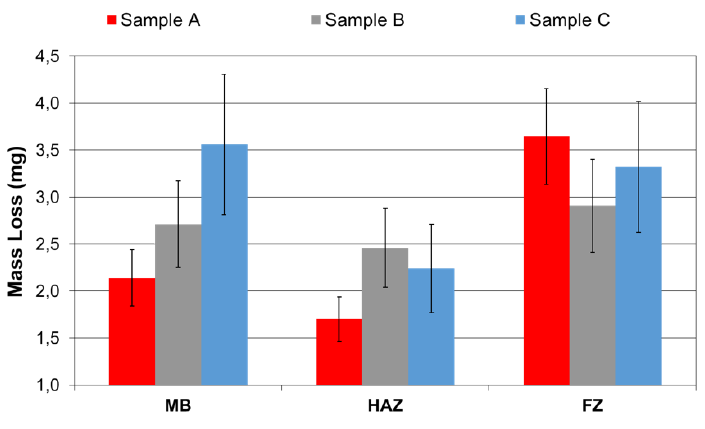
Figure 2. Mass loss in the sample zones.